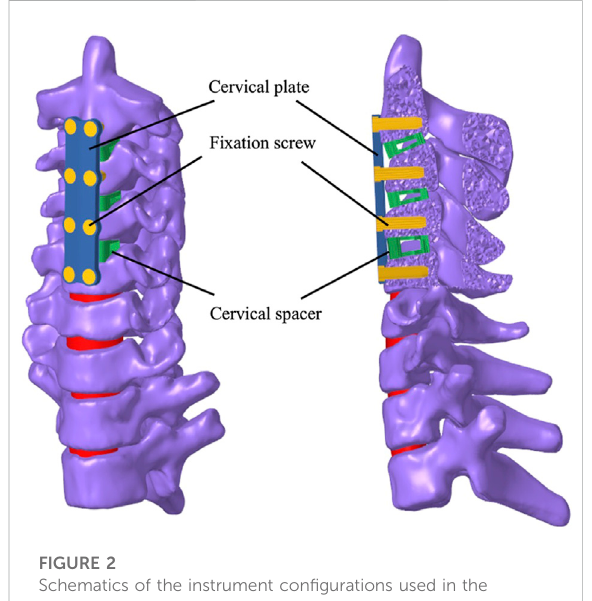
FIGURE 2 Schematics of the instrument con fi gurations used in the ACDF surgery.